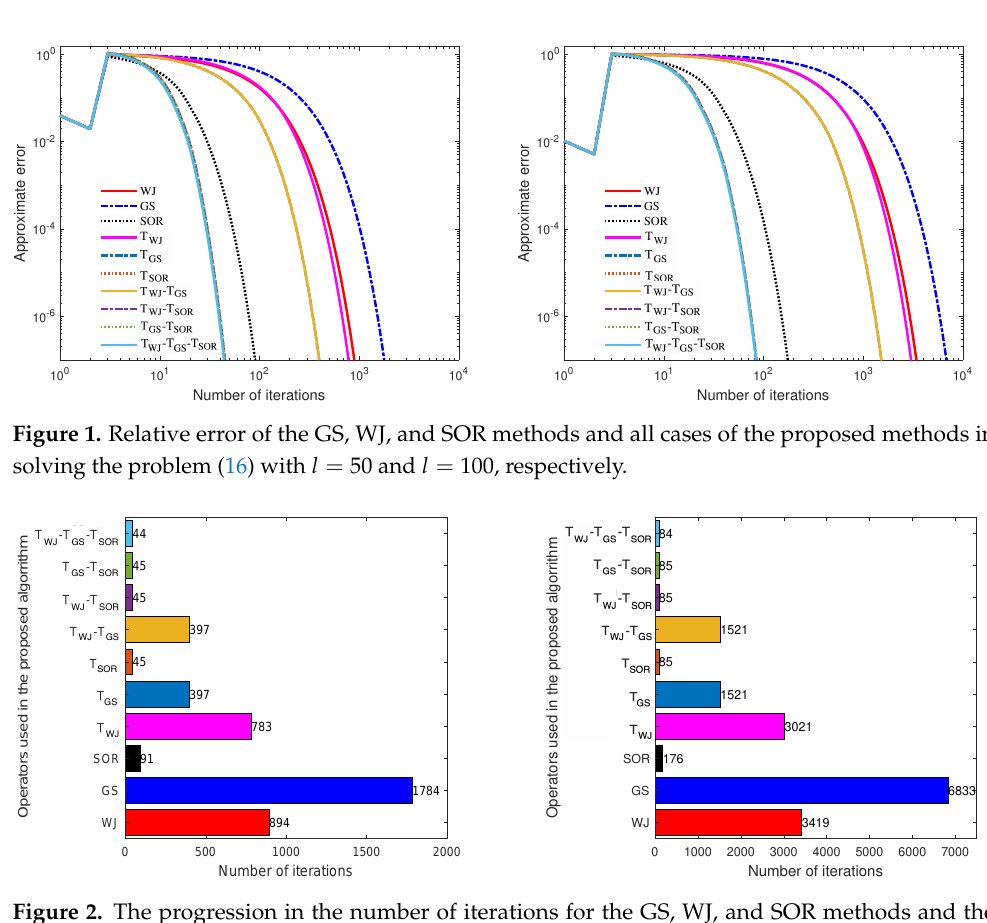
Figure 2. The progression in the number of iterations for the GS, WJ, and SOR methods and the proposed methods in solving the problem (12)) with l = 50 and l = 100,